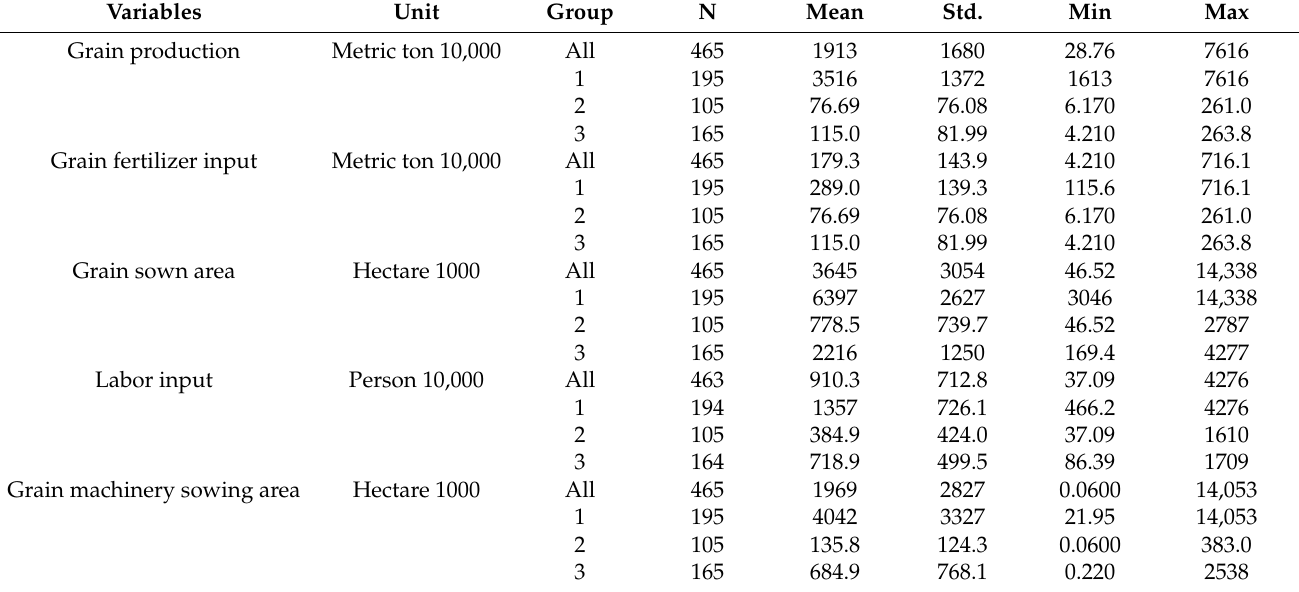
Table 1. Descriptive statistic of grain production